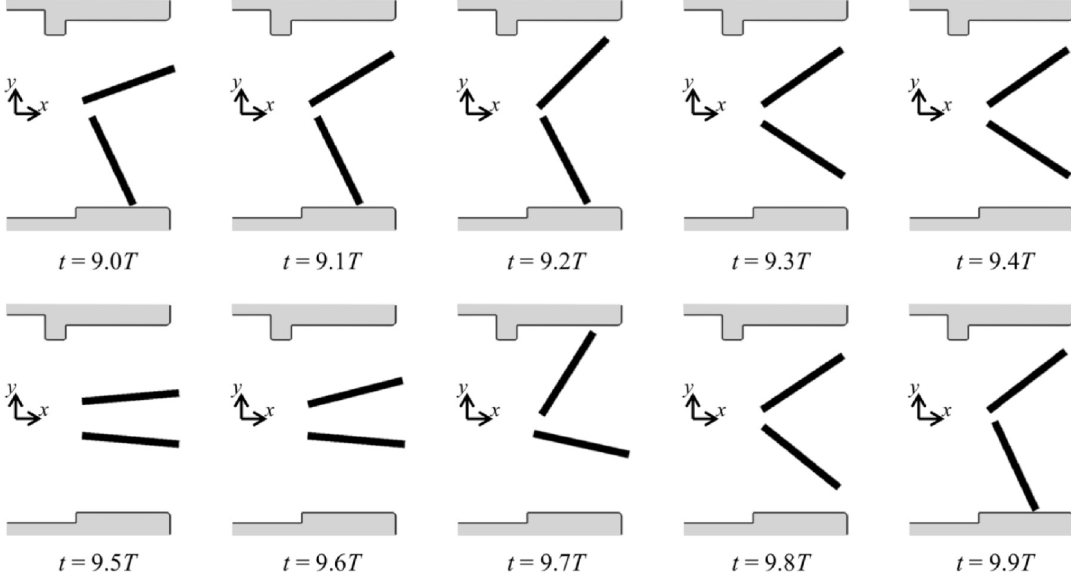
Fig 7. Leaflet motion during a cardiac cycle ( T ) for the case of upper semi-circular pannus ( h = 0.12 D ).